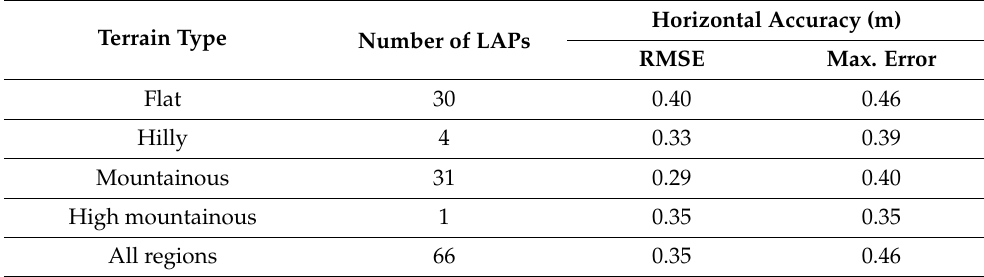
Table 5. Relative horizontal accuracies of GF7 LAPs and GF7 stereo images from orbit 3267. Terrain